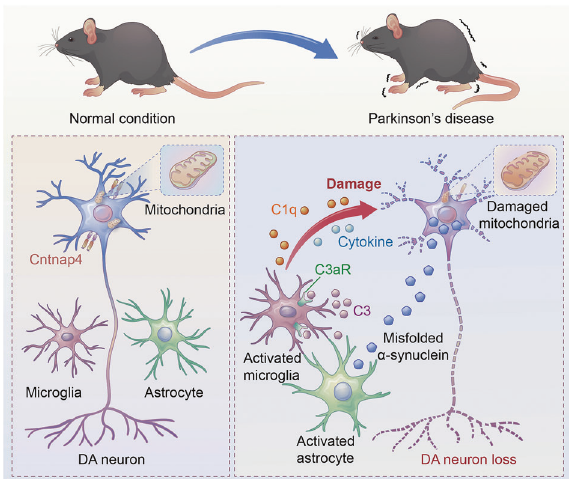
Fig. 9 Schematic model of this study. Cntnap4 partial de fi ciency augments DA neuronal death mediated by α -synuclein burden. Damaged DA neurons then release α -synuclein and induce the astrocyte – microglia crosstalk, which leads to astrocytic release of complement C3. Upon activation by the C3a receptor, microglia secretion of complement C1q and pro-in fl ammatory cytokines further drives DA neuronal death and aggravates motor dysfunction in